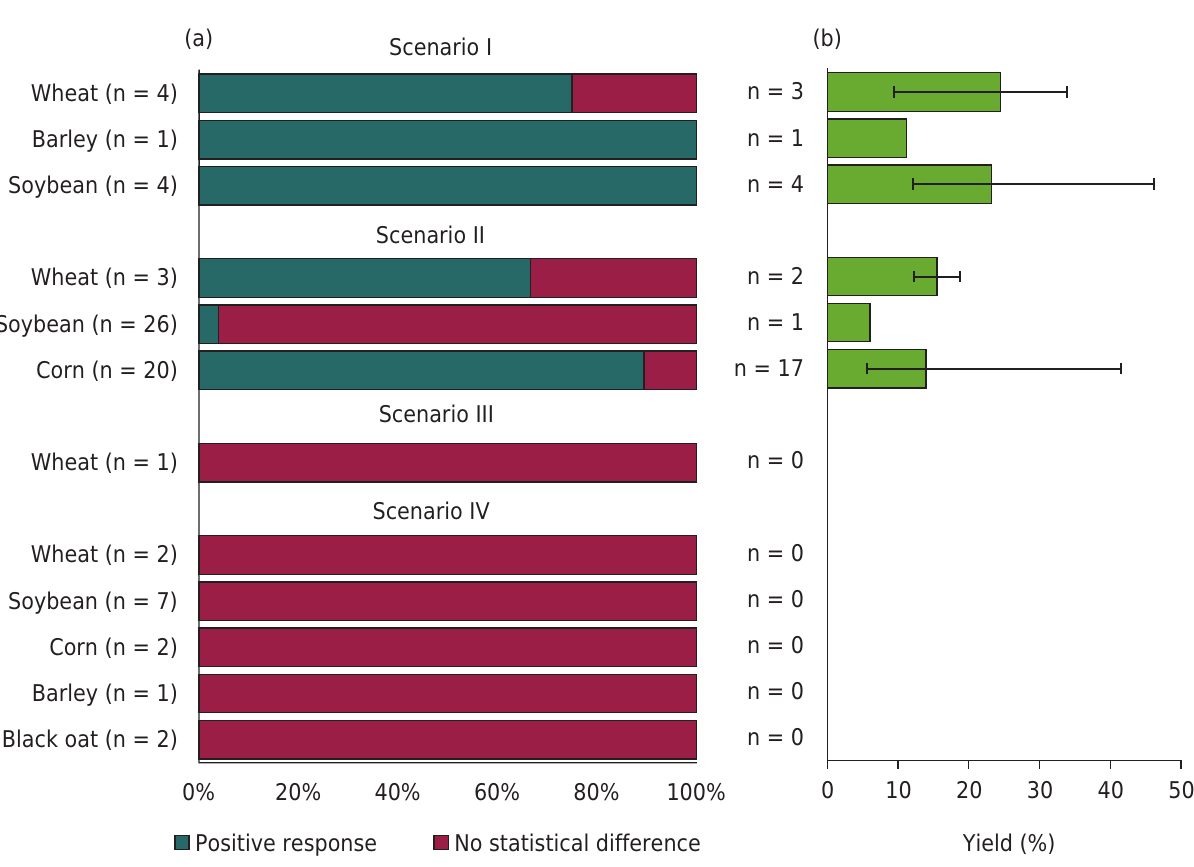
Figure 6. Crop response to gypsum application in different scenarios considering a critical level of Al saturation of 10 % and/or of exchangeable Ca content of 3.0 cmol c dm -3 (a). Average increase in grain yield in response to gypsum in subtropical soils under no-tillage in South of Brazil (b). Scenario I: water deficiency and high soil subsurface acidity; Scenario II: no water deficiency and high soil subsurface acidity; Scenario III: water deficiency and low soil subsurface acidity; and Scenario IV: no water deficiency and low soil subsurface